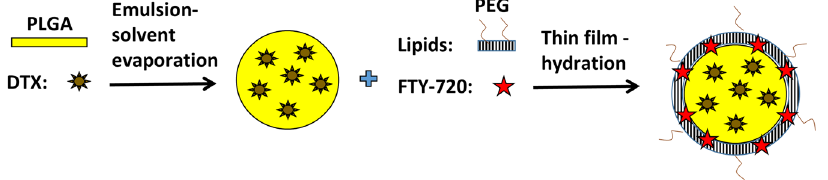
Figure 1. Scheme of CSLPHNPs synthesis and drug loading. Schematic representation of the preparation of CSLPHNPs with a multiple layer-by-layer structure. Briefly, organic solution containing PLGA and docetaxel was emulsified into an aqueous solution of PVA by slow injection with homogenization. After removing of any residual solvent, the nanoparticle-size fraction was recovered by ultracentrifugation. The smallest size fraction of PLGA nanoparticles aqueous solution was added to the lipid film containing phospholipids, cholesterol and FTY720 mixture to form CSLPHNPs. The resulting CSLPHNPs were extruded through a 200 nm membrane, purified and collected by Amicon centrifugal device. DTX,